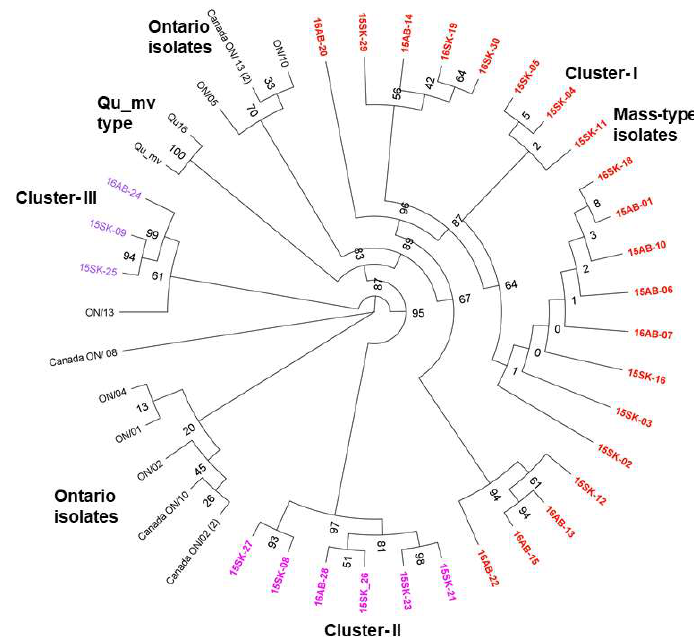
Figure 3. Phylogenetic tree of 42 Canadian IBV isolates: Maximum likelihood phylogenetic tree inferred based on the deduced amino acid sequences of the partial S1 gene is shown. The bootstrap support for each node is shown (current SES isolates are color-coded and depicted in bold).